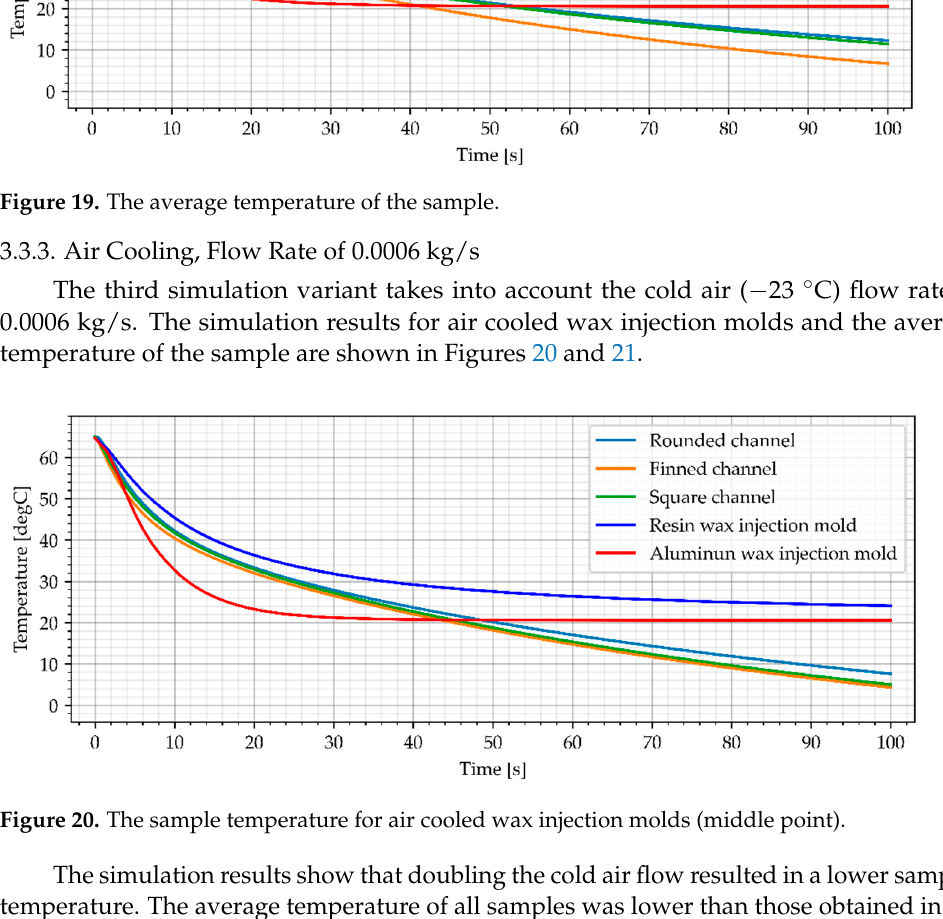
Figure 21. The average temperature of the sample. The simulation results show that doubling the cold air flow resulted in a lower sam- ples temperature. The average temperature of all samples was lower than those obtained in the reference aluminum wax injection mold after 42 s (34 s for the finned version). The time difference needed to achieve better results for the cooled wax injection molds com- pared to the reference aluminum wax injection mold was not significant and amounted to between 44s for the finned channel and 48 s for rounded version. 3.3.4. Air Cooling, Flow Rate of 0.001 kg/s The last simulation variant takes into account the cold air (-23°C) flow rate of 0.001 kg/s. The simulation results for air cooled wax injection molds and the average tempera- ture of the sample are shown in Figures 22 and 23.